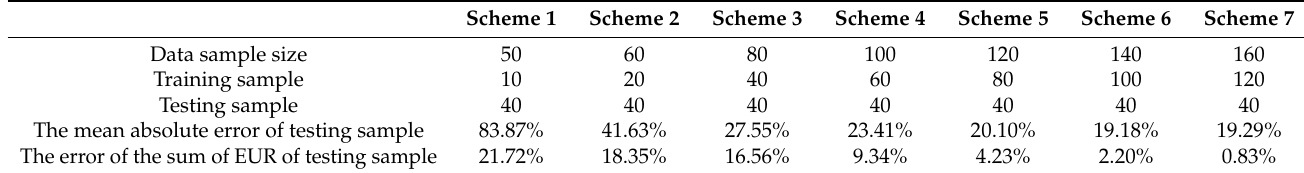
Table 7. The prediction results of different